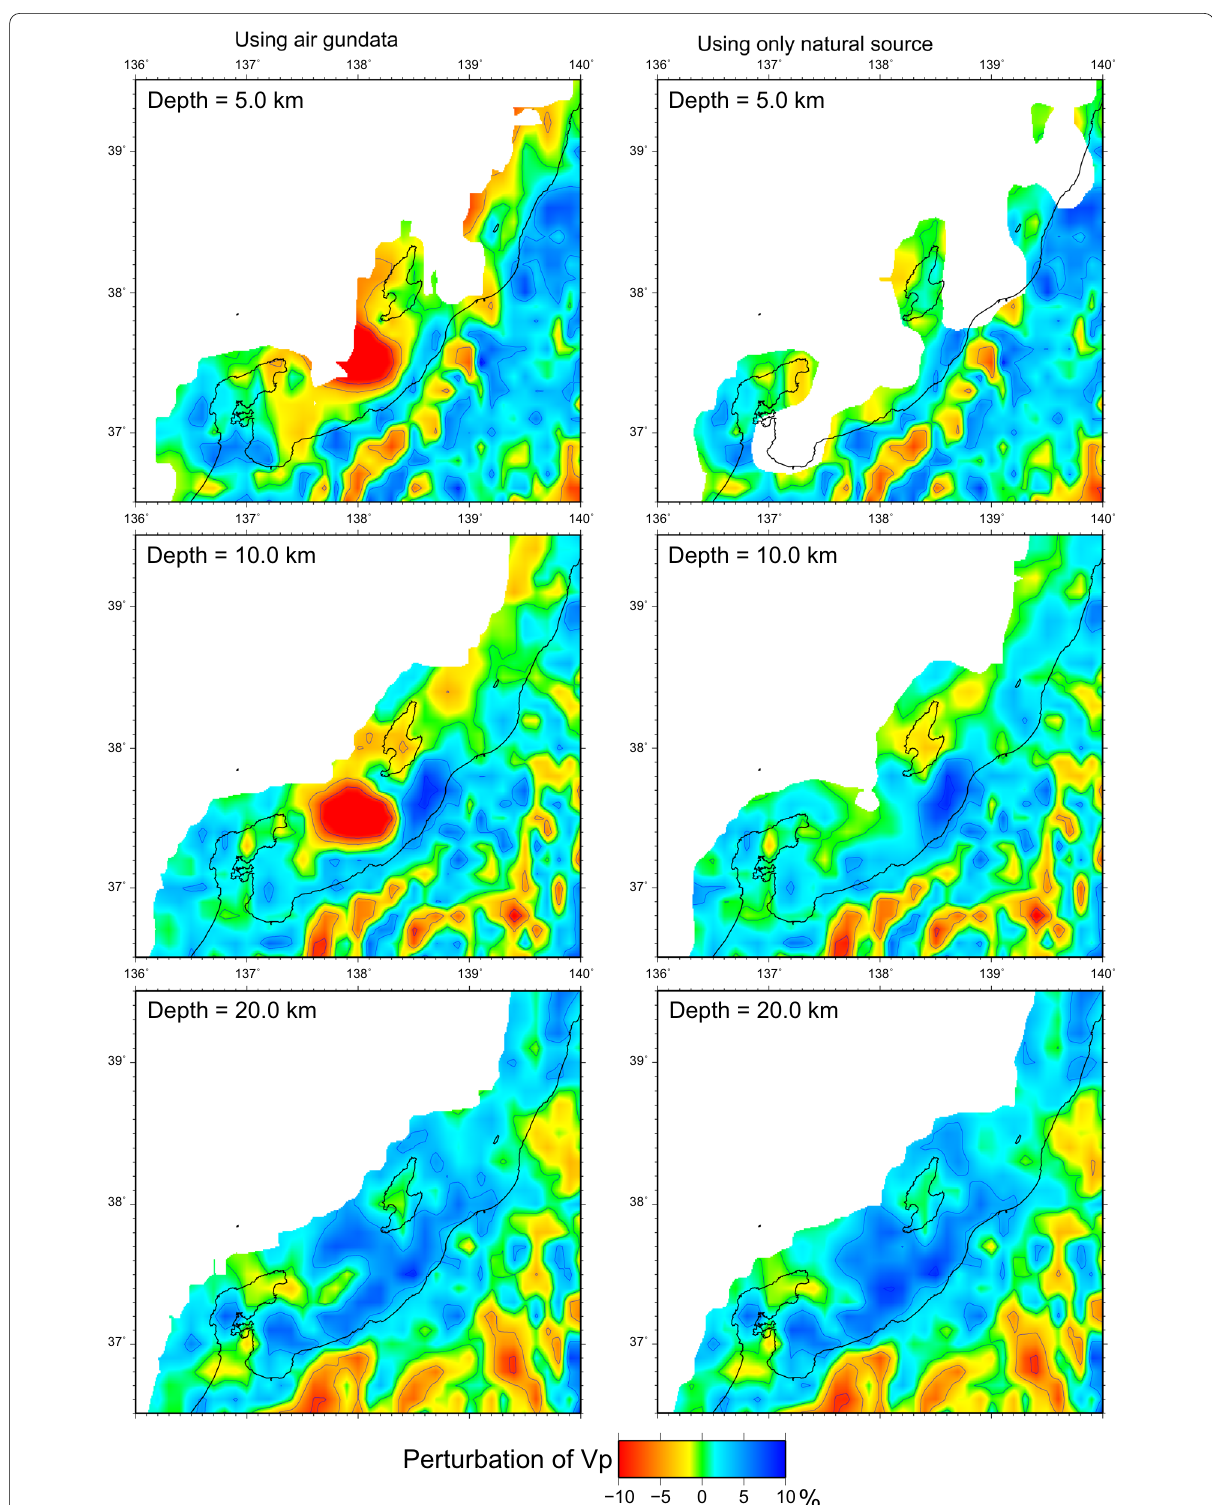
Fig. 15 Map views of Vp beneath the central coast of the Sea of Japan from Yamagata to Noto